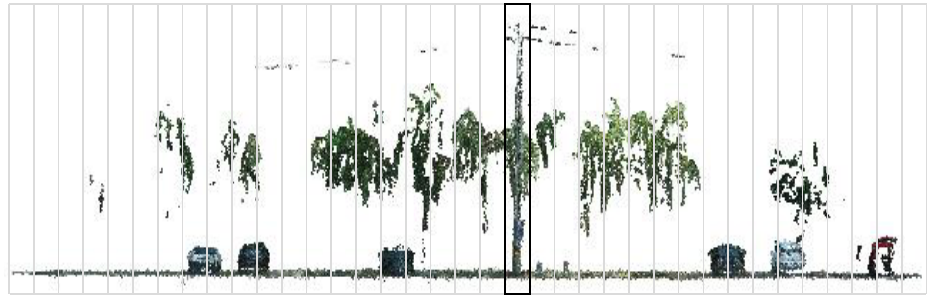
Figure 3. Partial cross-section view of the point cloud grid.